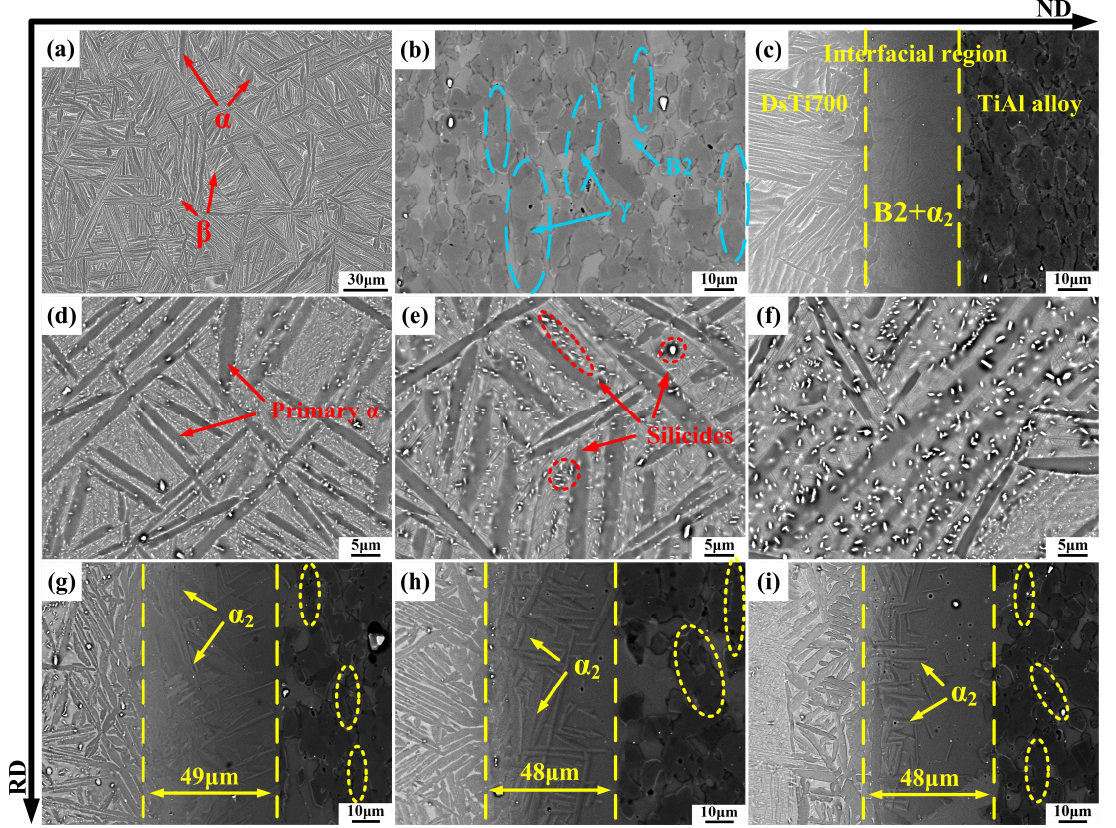
Figure 2. The cross-sectional microstructure of the initial and heat-treated composites: ( a ) DsTi700 alloy, ( b ) TiAl alloy and ( c ) interfacial region of initial composite; ( d ) DsTi700 alloy and ( g ) interfacial region of HT1; ( e ) DsTi700 alloy and ( h ) interfacial region of HT3, ( f ) DsTi700 alloy and ( i ) interfacial region of HT5.